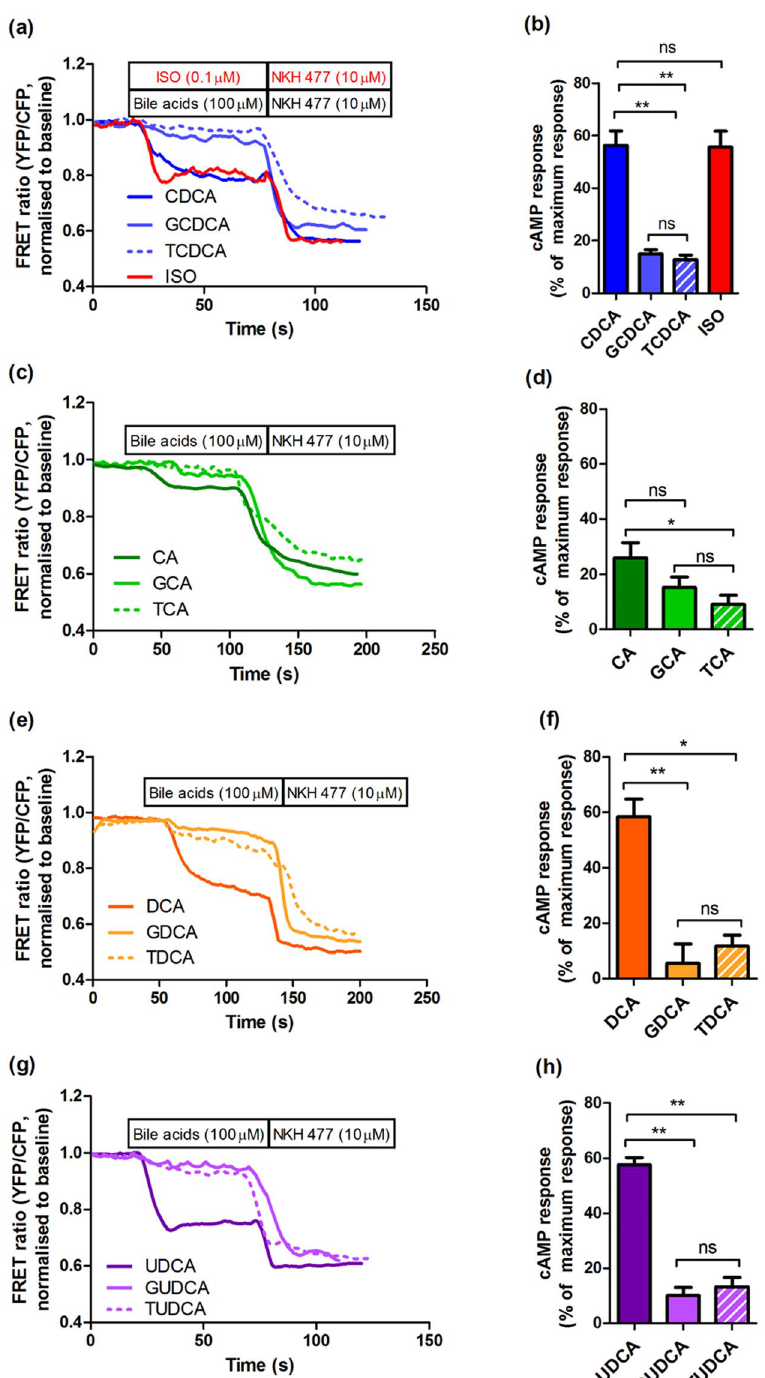
Figure 1. Unconjugated bile acids, but not their respective conjugates, elicit cAMP production in NMVMs. Representative traces of FRET in neonatal mouse cardiomyocytes (NMVMs) of cEpac-camps transgenic mice treated with ( a ) CDCA, ( c ) CA, ( e ) DCA and ( f ) UDCA with their respective tauro- and glyco-conjugates at 100 μ M; In ( a ) and ( b ) the cAMP response to isoproterenol (ISO) is also shown; Normalised cAMP responses of NMVMs following stimulation of ( b ) CDCA, ( d ) CA, ( f ) DCA and ( h ) UDCA with their respective tauro- and glyco-conjugates at 100 μ M (n = 6, * p < 0.05, ** p <